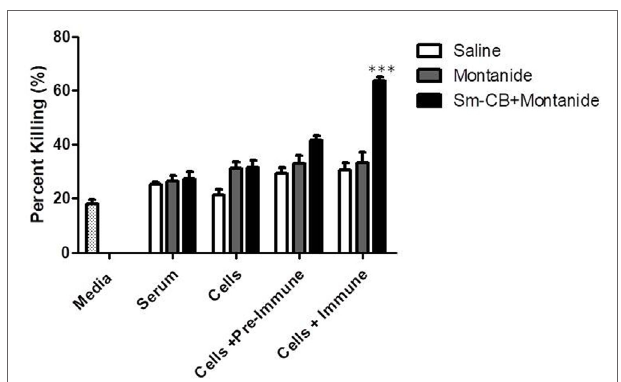
FigUre 1 | Schistosomula death with Schistosoma mansoni Cathepsin B (Sm-Cathepsin B) + Montanide. Sixty mechanically transformed schistosomula were incubated for 24 h at 37°C, 5% CO 2 in the presence of media, serum, cells, cells + pre-immune serum, or cells + immune serum. CD45 + lung cells and serum were collected from the different immunized mouse groups: saline, Montanide ISA 720 VG, and Sm-Cathepsin B + Montanide ISA 720 VG. Percent parasite killing was determined for all groups and conditions. n = 14 for all groups. *** p ≤